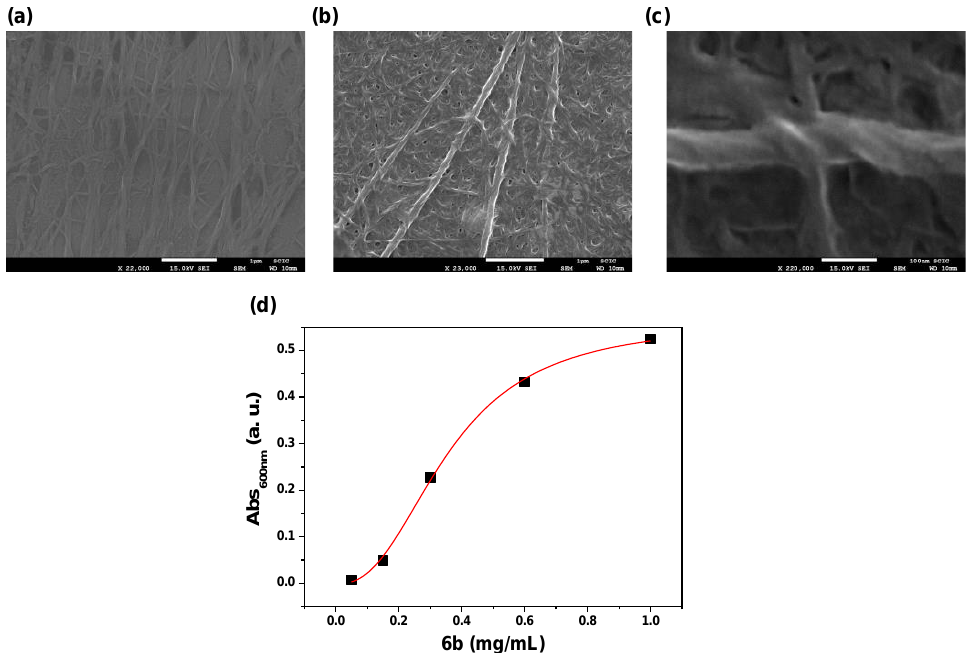
Figure 1. ( a – c ) SEM images for the dried sample of 6b (1 mg/mL) in DMSO:H 2 O (10:90) and ( d ) UV absorption at 600 nm for 6b at different concentrations in H 2 O:DMSO (90:10) [26]. The red line corresponds to the sigmoidal fitting calculated using Origin Software.